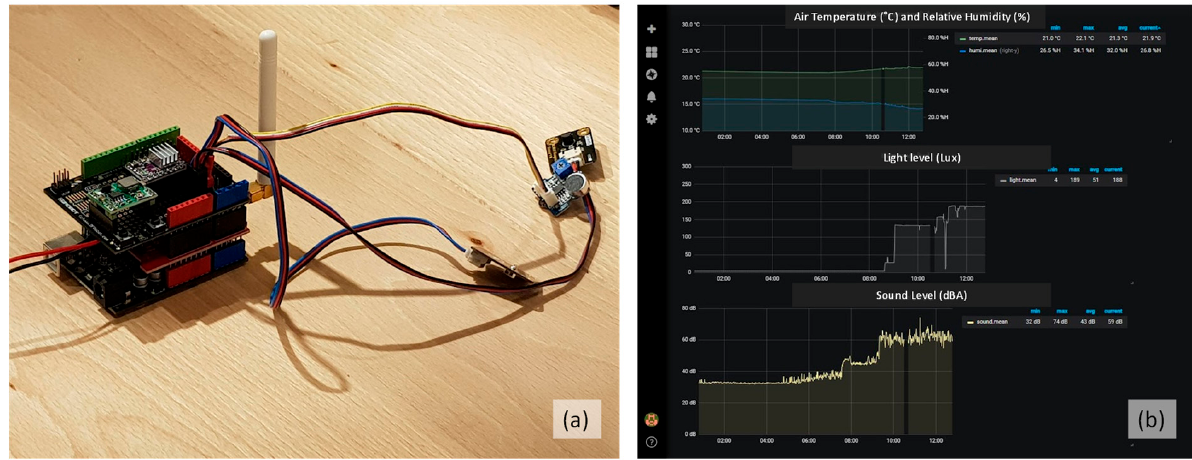
Figure 9. Example of ( a ) IoT sensors and ( b ) real-time data visualization of an indoor environment. Table 3 lists the relevant studies published during the years between 2020 and 2022 and conducted in various countries across the world. The next parts elaborate on certain aspects and limitations of IoT applications, and how they are being utilized in building monitoring and data visualization for energy Table 3. Summary of recent studies on IoT-based building monitoring and IoT-based data visuali- zation techniques.